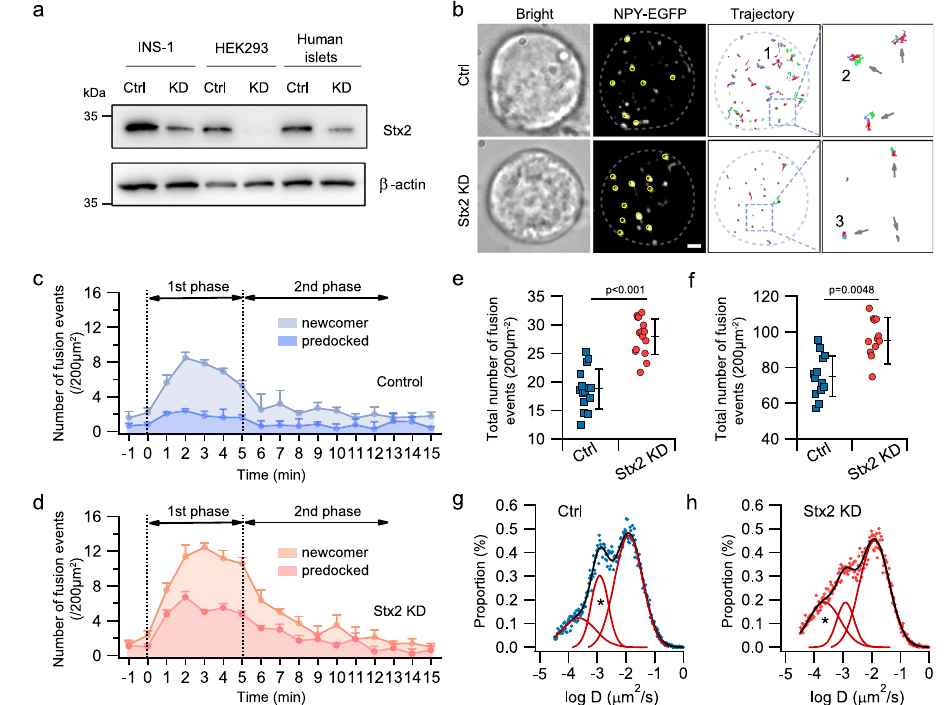
Fig.1|Stx2deletionincreasesexocytosisofpredockedandnewcomergranules in human β -cells. a Representative western blot ( n =3 independent experiments, analysisinSupplementary Fig. 1a)showing the ef fi ciency of Stx2 KD(seeMethods) inhumancells(HEK293Acell,humanislets)andrat β -cells(INS832/13). β -actinused as loading control. b Representative TIRFM images monitoring the behavior of granules with the fl uorescent granule marker neuropeptide-Y-EGFP (NPY-EGFP). Yellow circles indicate the sites of granule fusion events for Stx2-KD and Control (Ctrl)human β -cells.Granuletrajectoriesareshownonthe right